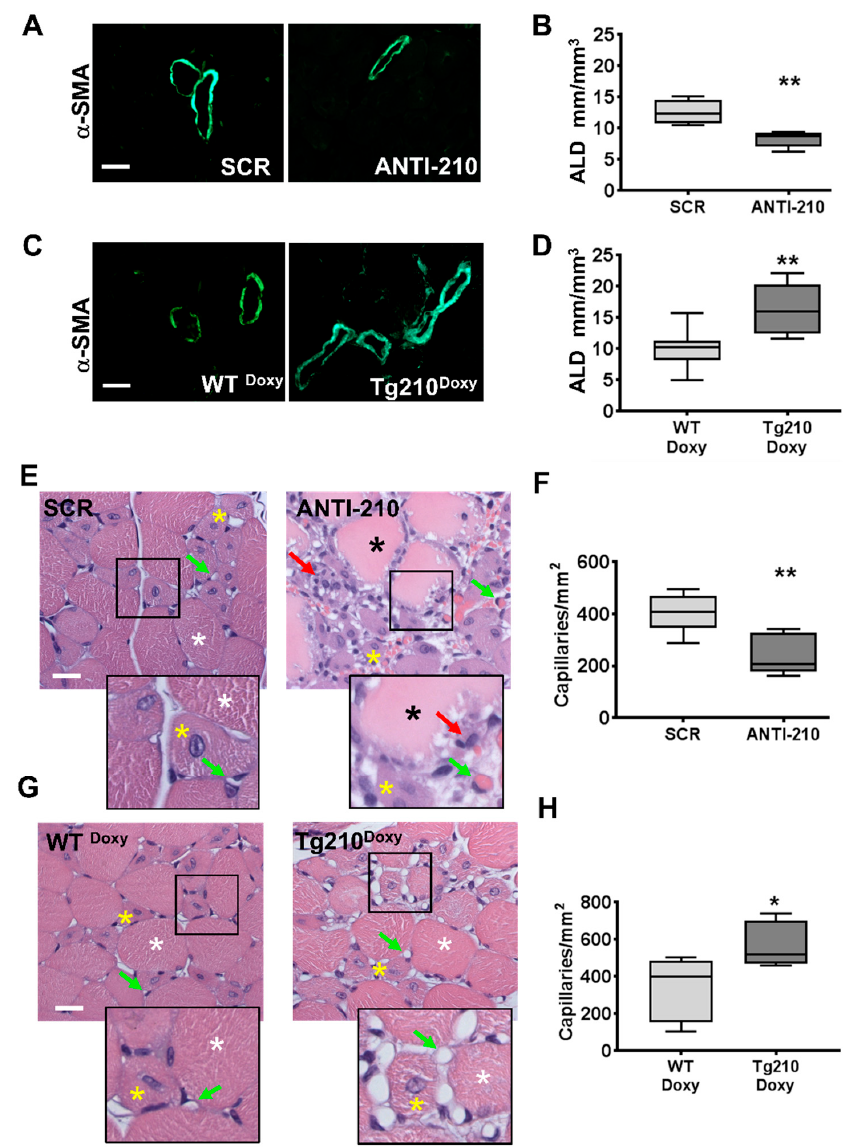
Figure 2. MiR-210 modulates arteriolar length density and capillary density. ( A , C ) Representative α -SMA immunofluorescence staining of ( A ) SCR and ANTI-210 and ( C ) WT Doxy and Tg210 Doxy gastrocnemius muscle sections, 7 days after ischemia. Magnification is set at 400 × , and the calibration bar is 20 µ m. ( B , D ) Box plots show quantification of Arteriolar length density (ALD) (lumen minor diameter range: 4–10.99 µ m) in SCR and ANTI-210 muscles ( B : n = 5; test t ** p = 0.005) and in WT Doxy and Tg210 Doxy mice ( D : n = 6–10; test t ** p < 0.005). ( E , G ) Representative hematoxilin / eosine stained sections of ischemic gastrocnemius muscles of ( E ) SCR and ANTI-210, ( G ) WT Doxy and Tg210 Doxy at day 7 after ischemia. Magnification is set at 400 × , and the calibration bar is 20 µ m. Green arrows indicate capillaries (that may contain an erythrocyte); red arrows indicate inflammatory infiltrating cells; white asterisks indicate healthy myofibers; yellow asterisks indicate regenerating myofibers; black asterisks indicate damaged myofibers. The insets show tissue structure at a higher magnification. F and H: Box plots show quantification of capillaries / mm 2 in SCR and ANTI-210 muscles ( F : n = 6, test t ** p = 0.007) and in WT Doxy and Tg210 Doxy muscles ( H : n = 6–10, test t * p =